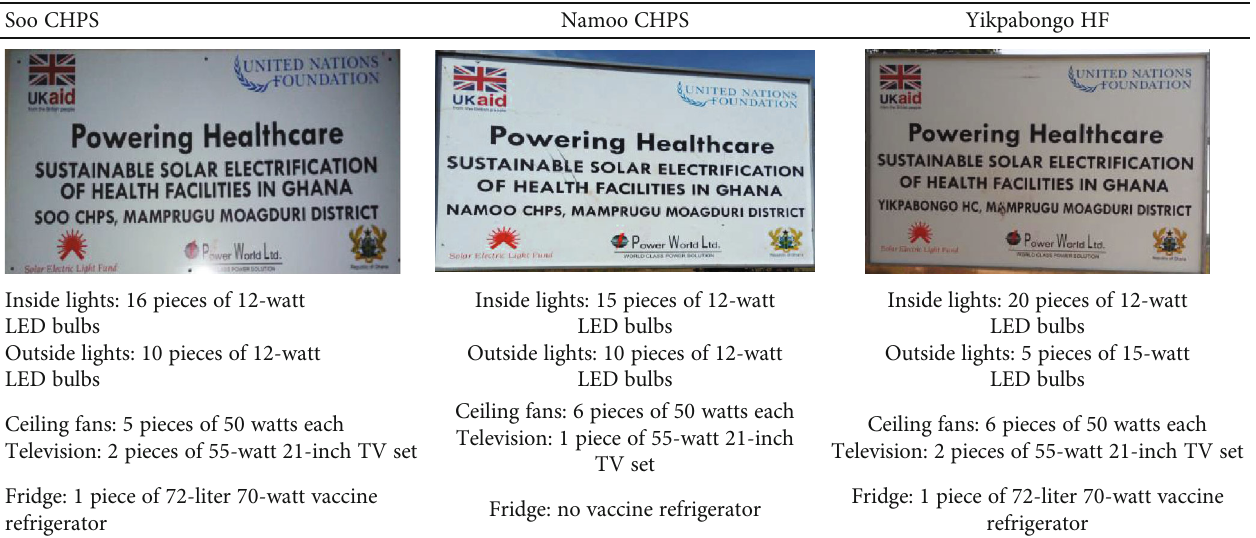
Table 1: Electrical appliances at the 3 CHPS in the Mamprugu Moagduri District.